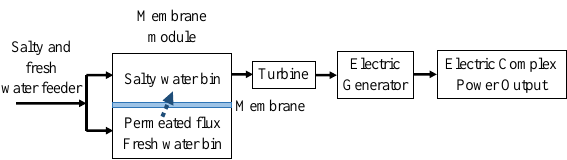
Fig. 1. Generic representation of a PRO